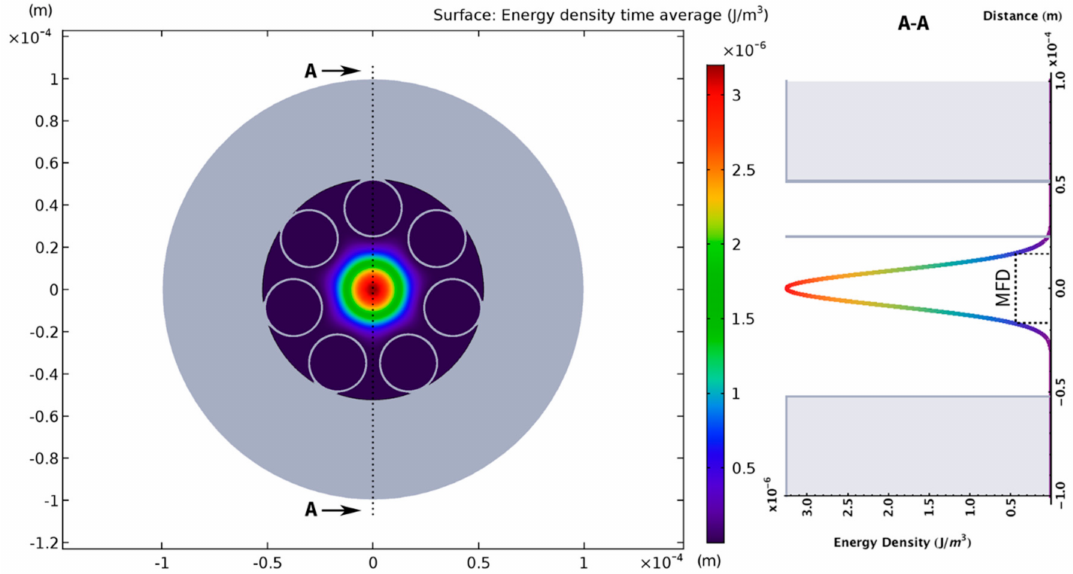
Figure 2. Schematic light field intensity overlapping with the glass structure in an antiresonant fiber